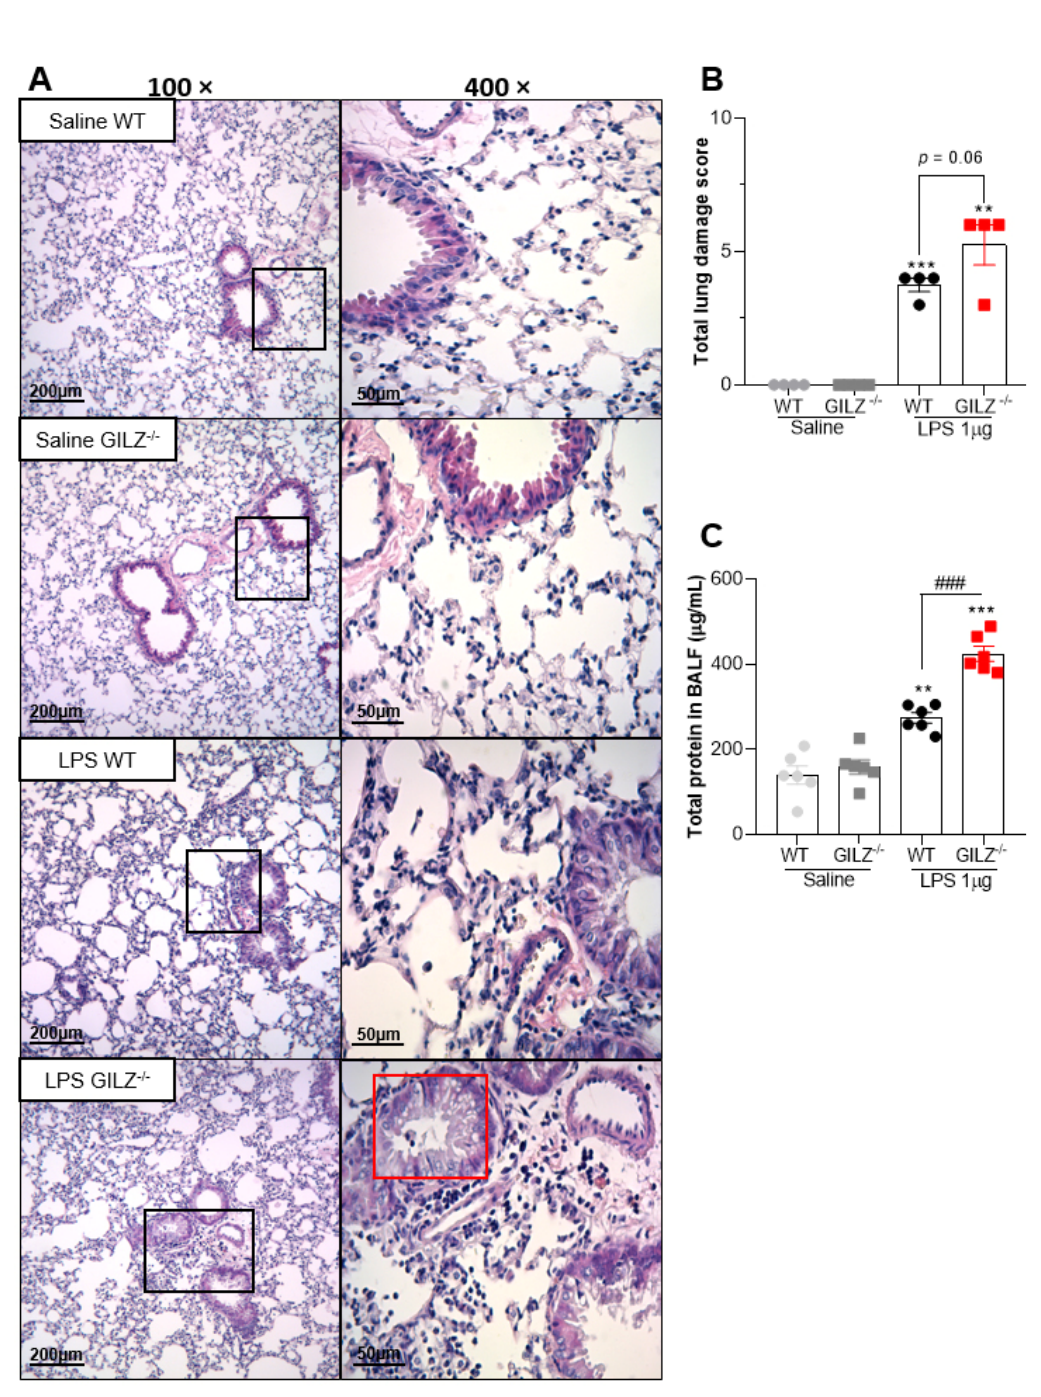
Figure 2. GILZ deficient mice show exacerbation of LPS-induced Acute Lung Injury. C57BL/6 WT or GILZ − / − mice were stimulated with LPS (1 μ g, i.n.) and euthanized 24 h later. Representative slides of hematoxylin and eosin (H&E) stained lungs are shown ( A ). Scale bars = 200 μ m (low magnification) and 50 μ m (high magnification). Right slides are higher magnifications (400×) of the selected areas (boxes) in left slides (100×). Histopathological score evaluated airway, vascular, and parenchymal inflammation, neutrophilic infiltration, and epithelial injury ( B ). A red box represents bronchiolar epithelium degeneration, seen only in LPS-instilled GILZ − / − group of mice. The levels of total protein in BALF were evaluated ( C ). Data are mean ± SEM of N = 4 animals (histopathology) or N = 6 (protein levels) per group. ** p < 0.01 or *** p < 0.001 when compared to saline instilled groups; or as indicated: ### p < 0.001 by 2-way ANOVA or p = 0.06 when comparing LPS-challenged GILZ − / − to WT mice ( t test).